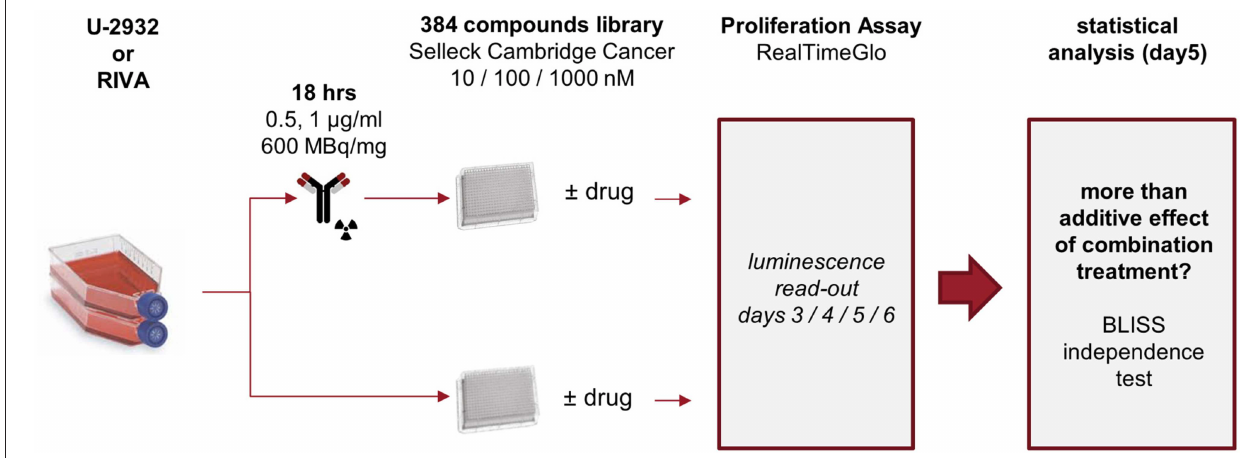
FIGURE 2 | Experimental layout. U-2932 and RIVA cells were treated with 1 or 0.5 µ g/mL 177 Lu-lilotomab satetraxetan (600 MBq/mg) for 18h, excess 177 Lu-lilotomab satetraxetan removed, and cells seeded onto 384-well plates pre-printed with the 384-compound Cambridge Cancer compound library sourced from Selleckchem at final concentrations of 10nM, 100nM, or 1 µ M. Untreated control cells were seeded on parallel plates. Viability measurements, using RealTime-Glo, were carried out between day 3 and 6 after seeding. Inhibitory compounds were considered as candidate hits if they: (1) in combination with 177